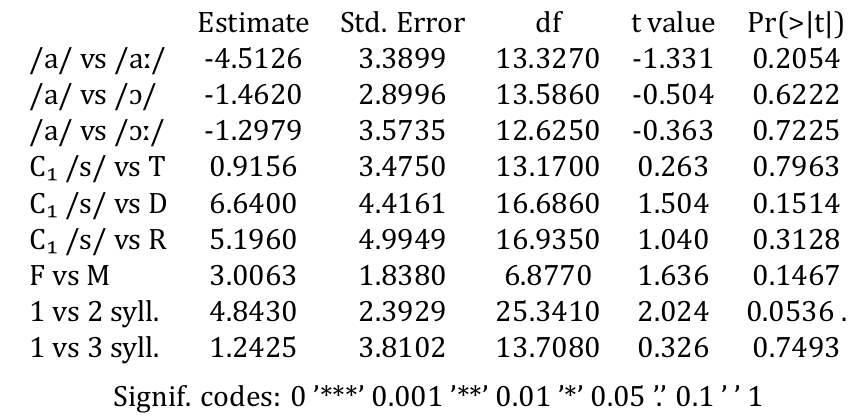
Table A.19: Pre-aspiration duration (ms) of C₂ fortis plosive as a dependent variable